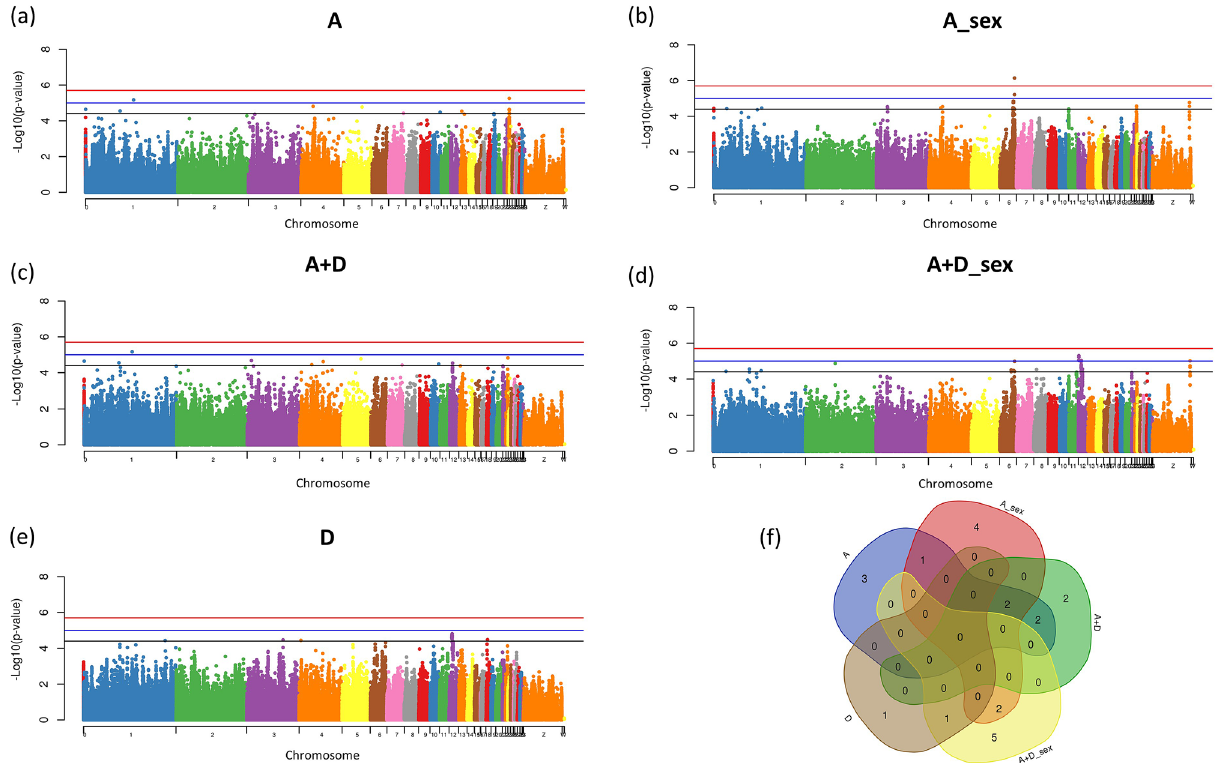
Figure 3. Manhattan plots of genome-wide association study for body weight gain (BWG). The Manhattan plot indicates the −log10 (p-values) for genome-wide SNPs (y-axis) plotted against their respective positions on each chromosome (x-axis). The horizontal red, blue and black lines indicate the 5% genome-wide significant (4 × 10 – 6 ), moderate (1 × 10 –5 ) and suggestive (4 × 10 –5 ) thresholds, respectively. The Manhattan plots are presented fitting five different SNP effects in the model: ( a ) additive effect (A); ( b ) additive fit in each sex (A_sex); ( c ) additive plus dominance (A + D); ( d ) additive plus dominance fit in each sex (A + D_sex); ( e ) dominance (D). The ( f ) is a Venn diagram summarizing the number of significant SNPs identified when each different SNP effect was fit in the model. The Venn diagram was constructed using a Bioinformatics and Evolutionary Genomics tool available in http://bioin forma tics.psb.ugent .be/webto